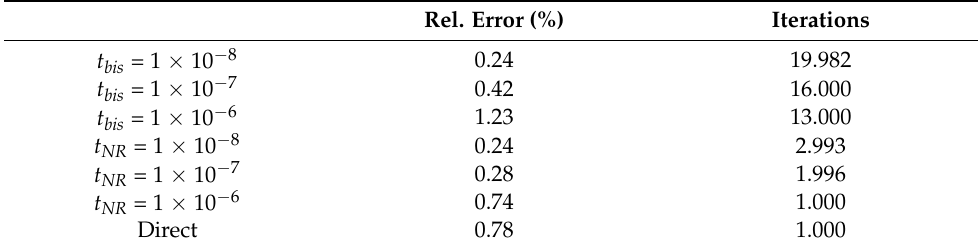
Table 2. Comparison of results for single element under tensile loading.